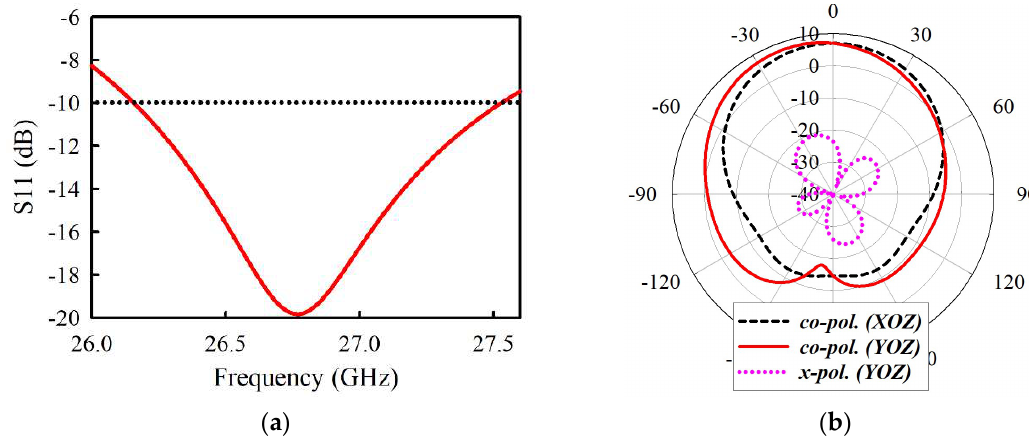
Figure 3. Simulation results of the element antenna: ( a ) Radiation efficiency in variation of coupling slot width, ws . ( b ) Gain and radiation efficiency. Table 1. Dimensions of the Element Patch Antenna.